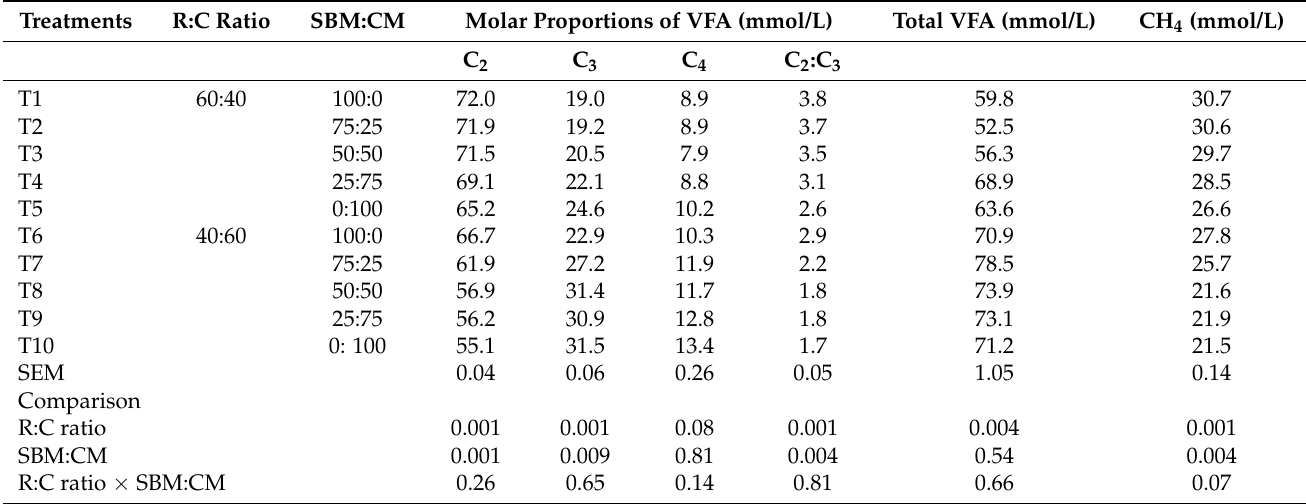
Table 3. Effect of cricket meal ( Gryllus bimaculatus ) (CM) on in vitro gas production, proportions of volatile fatty acids, and methane